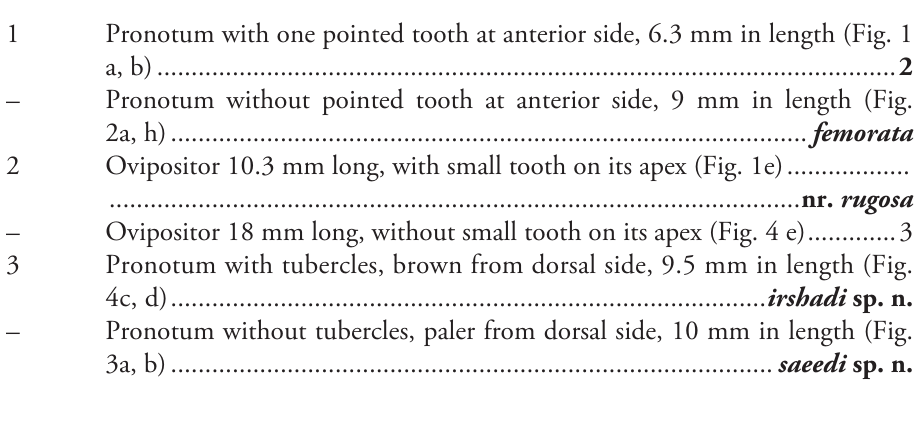
Diagnosis. Size medium to large, head usually short and rounded in appearance, face not slanting or flattened, head finely punctuated, forehead usually pale in color. Pronotum strong with or without tubercle on its apex. Ovipositor with or without spines on its apex. Sathrophyllia Stål, 1874